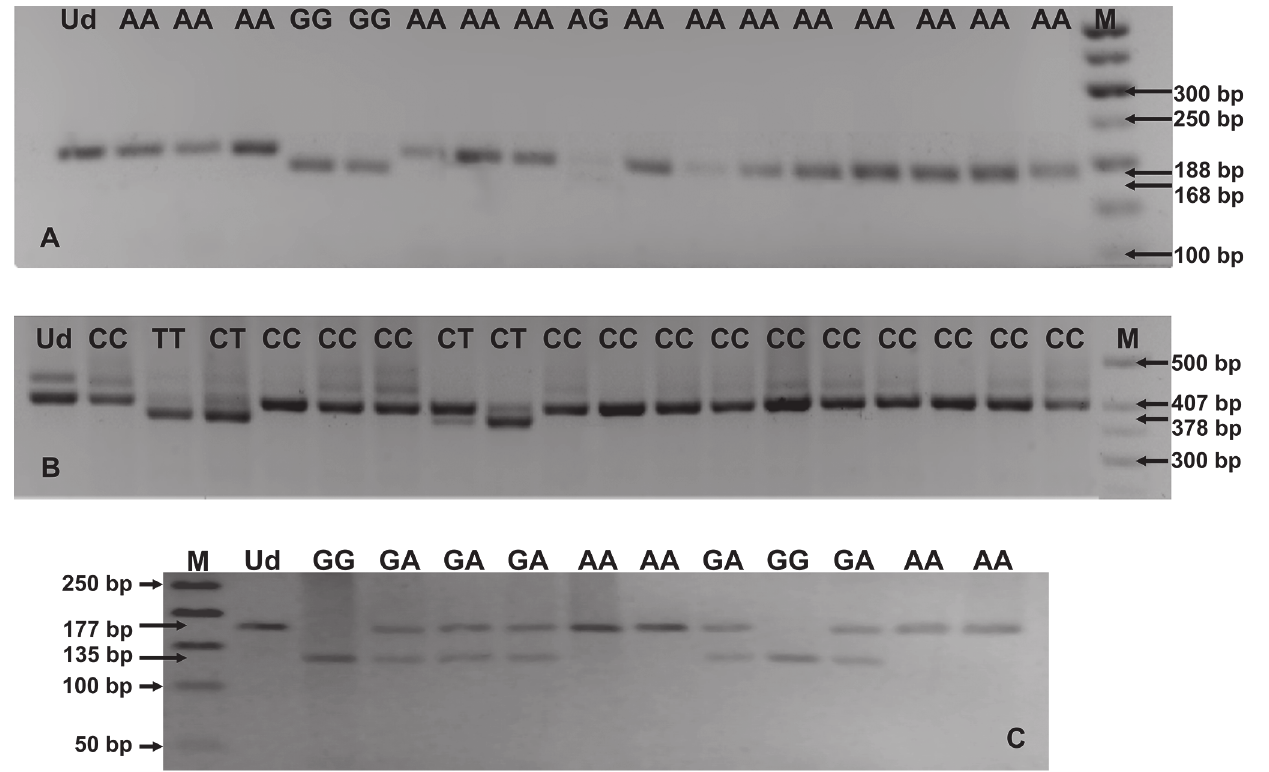
Fig 1. PCR-RFLP analysis of genotypes at TLR4 (A, B) and TLR9 (C) SNPs. RFLP products were resolved in 2% agarose gels, stained with ethidium bromide; A. TLR4 896 A > G SNP; B. TLR4 1196 C > T SNP; C. TLR9 2848 G > A SNP. The numbers on the side of electropherograms indicate the lengths of separated DNA fragments. M — 50 bp DNA marker; Ud — undigested PCR product; AA, AG, GG, GA, CC, CT or TT — genotypes at analyzed TLR SNPs.